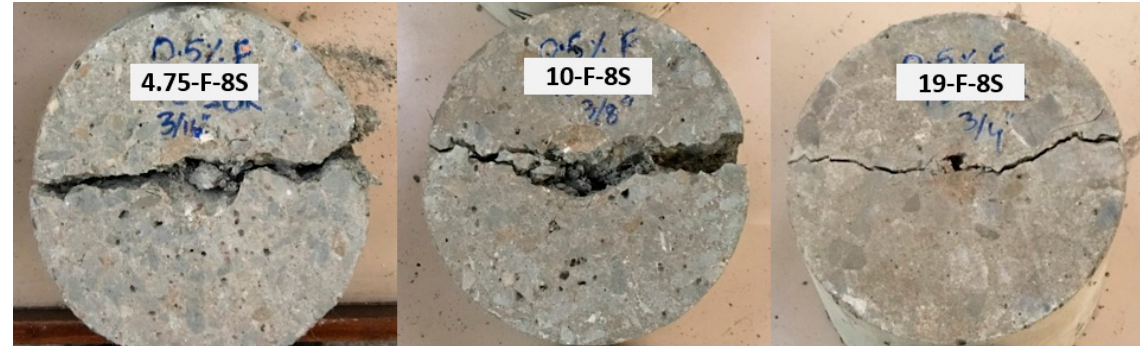
Figure 15. Failure pattern of the disc sample (center split pattern).